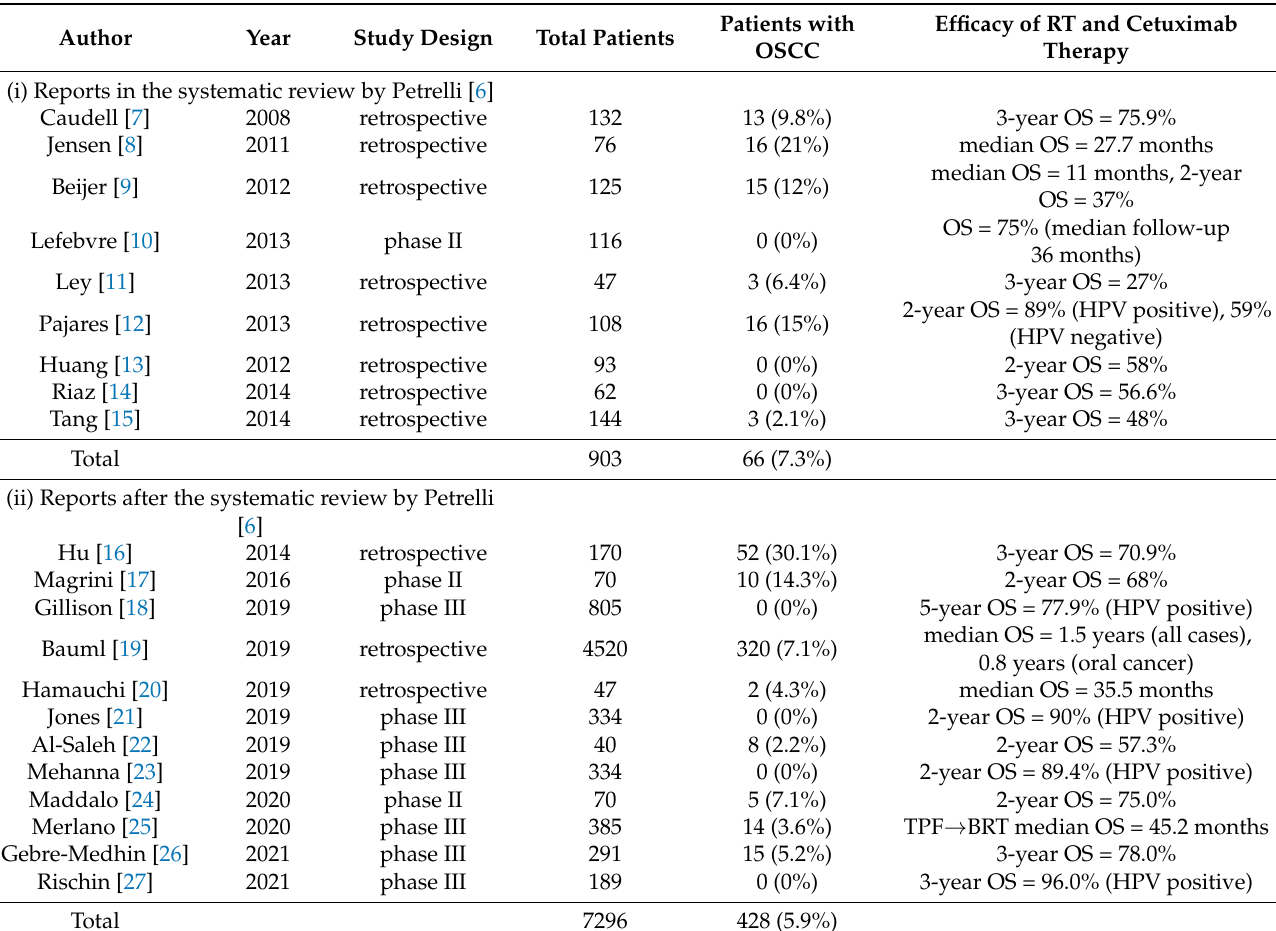
Table 1. Studies comparing RT and chemotherapy with RT and cetuximab in head and neck